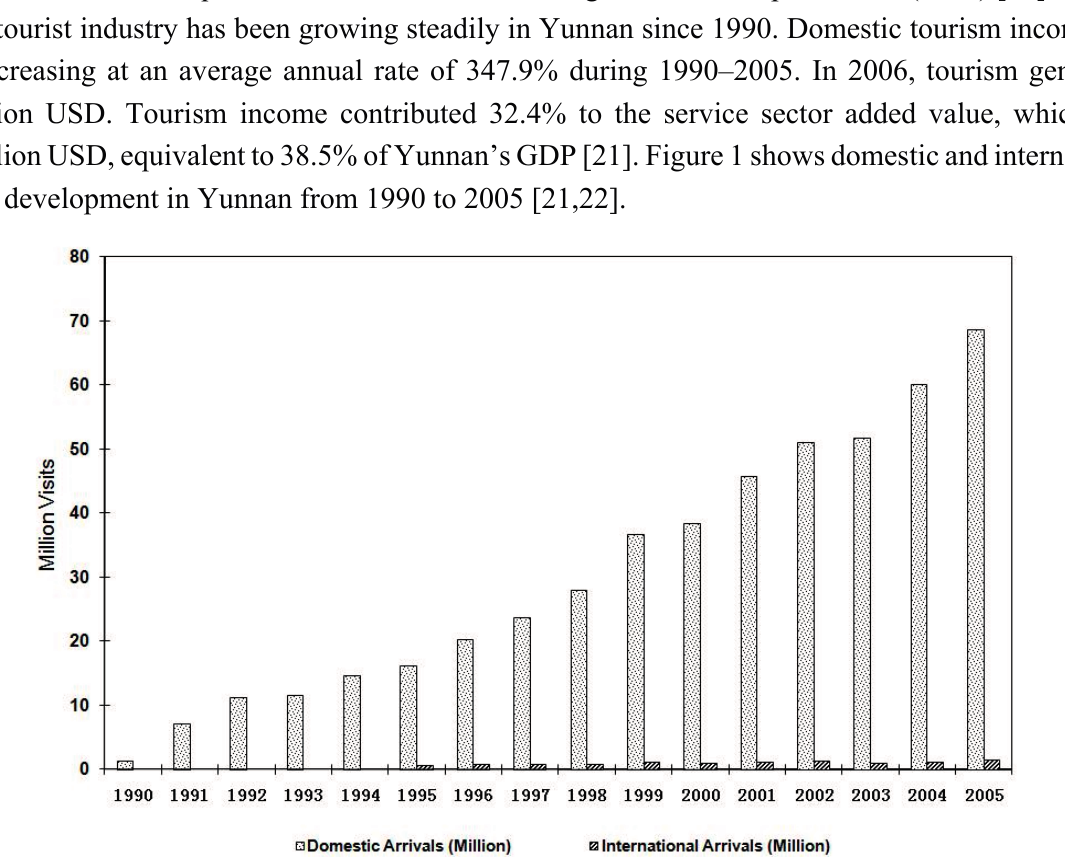
Figure 1. Tourism growth in